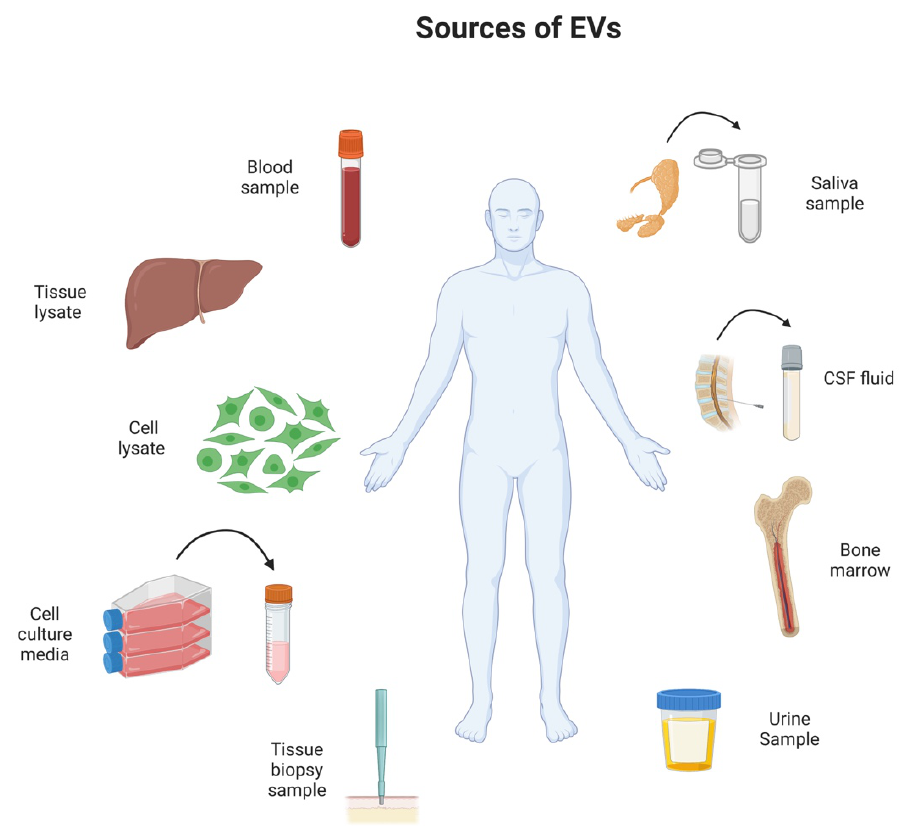
Figure 1. Schematic illustration depicting sources for EV collection. EVs can be isolated from various biological samples including bone marrow, cerebrospinal fluid (CSF), blood, urine, cell lysate, tissue lysate, cell culture media, and saliva and tissue biopsy.